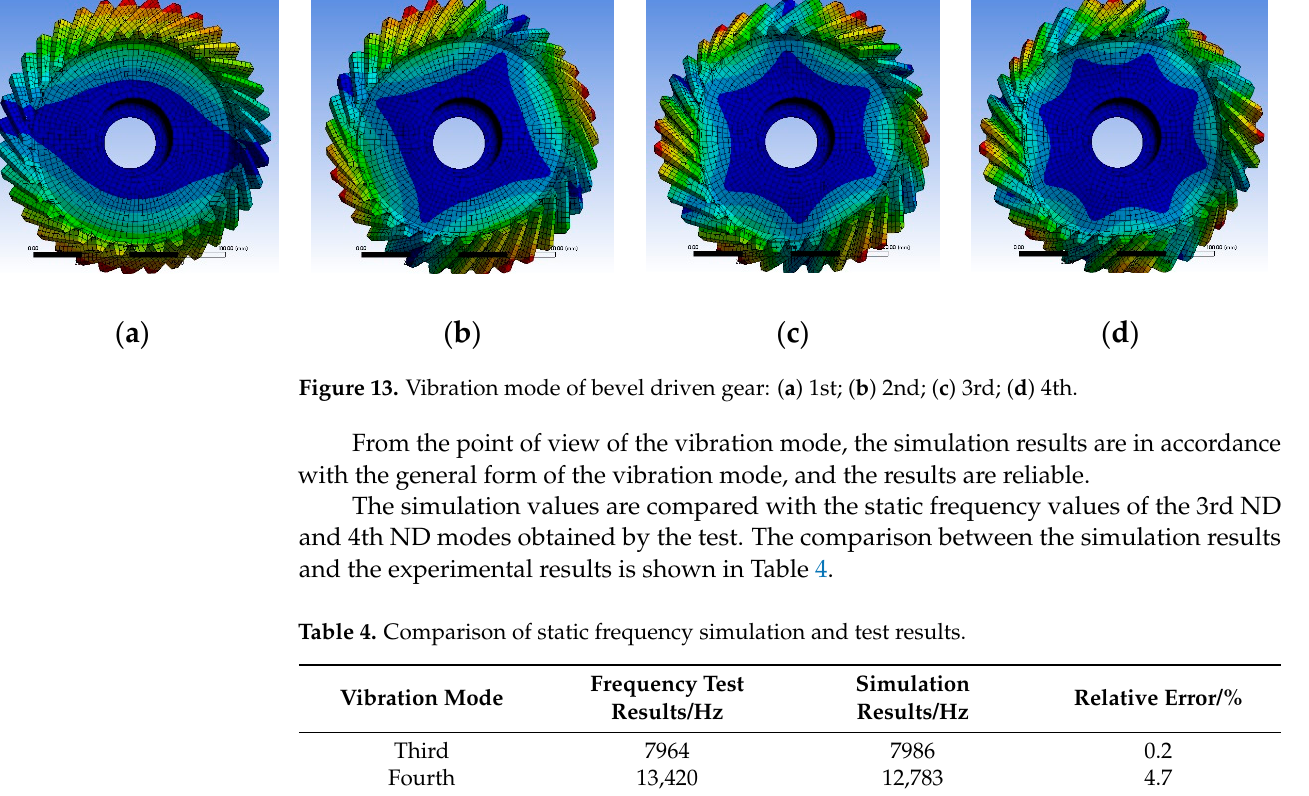
Table 3. Static frequency of vibration mode.